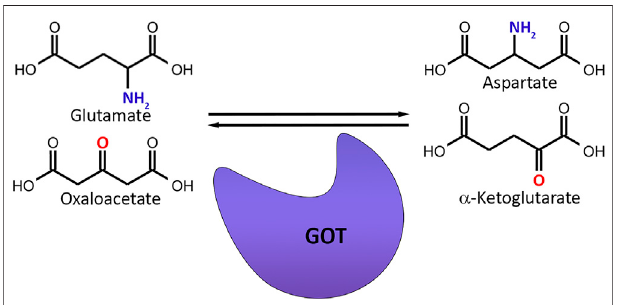
FIGURE 5 | Basic mechanism of glutamate scavenging. Glutamate- oxaloacetate Transaminase (GOT) transfers the amino group from glutamate to oxaloacetate while replacing the amino group of glutamate with a carbonyl group and converts glutamate and oxaloacetate to aspartate and α -